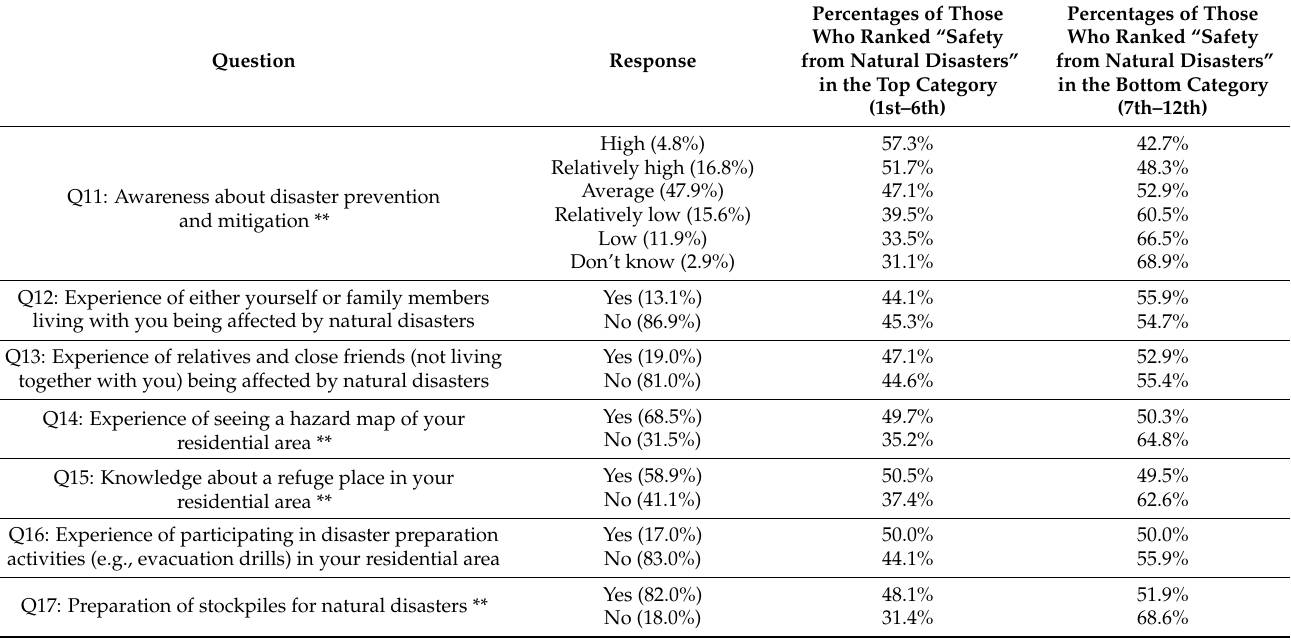
Table 3. Cross-tabulation results of disaster awareness, preparedness, and experiences and the relative preference of “safety from natural disasters” in residential choices ( n = 1554). The number in parentheses indicates the percentage of the response for each